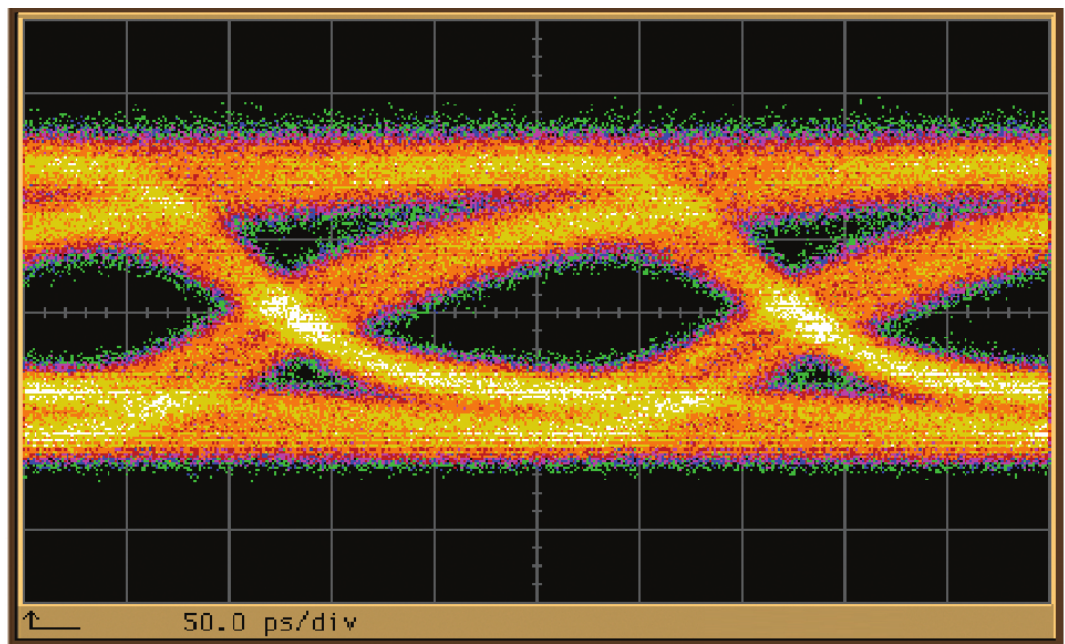
Figure 14. Eye diagram for 4 Gb/s encoded signal transmission over 21.35 km standard single-mode fiber after the RSOA-BFL. Vertical scale: 20